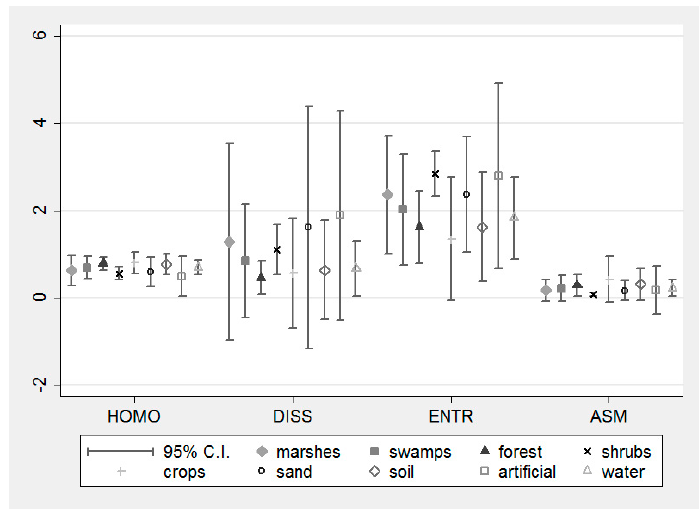
Figure 4. Mean values of texture indicators. Vertical axis represents the texture values for Normalized Difference Vegetation Index (NDVI).